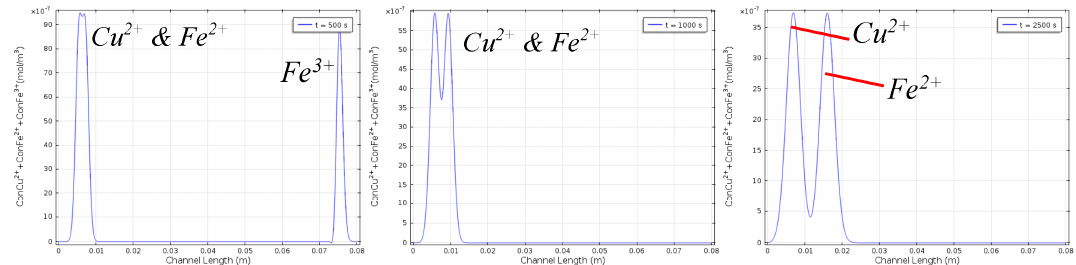
Figure 1. Simulation with EOF set to be about equal and opposite to the mobility of Cu 2+